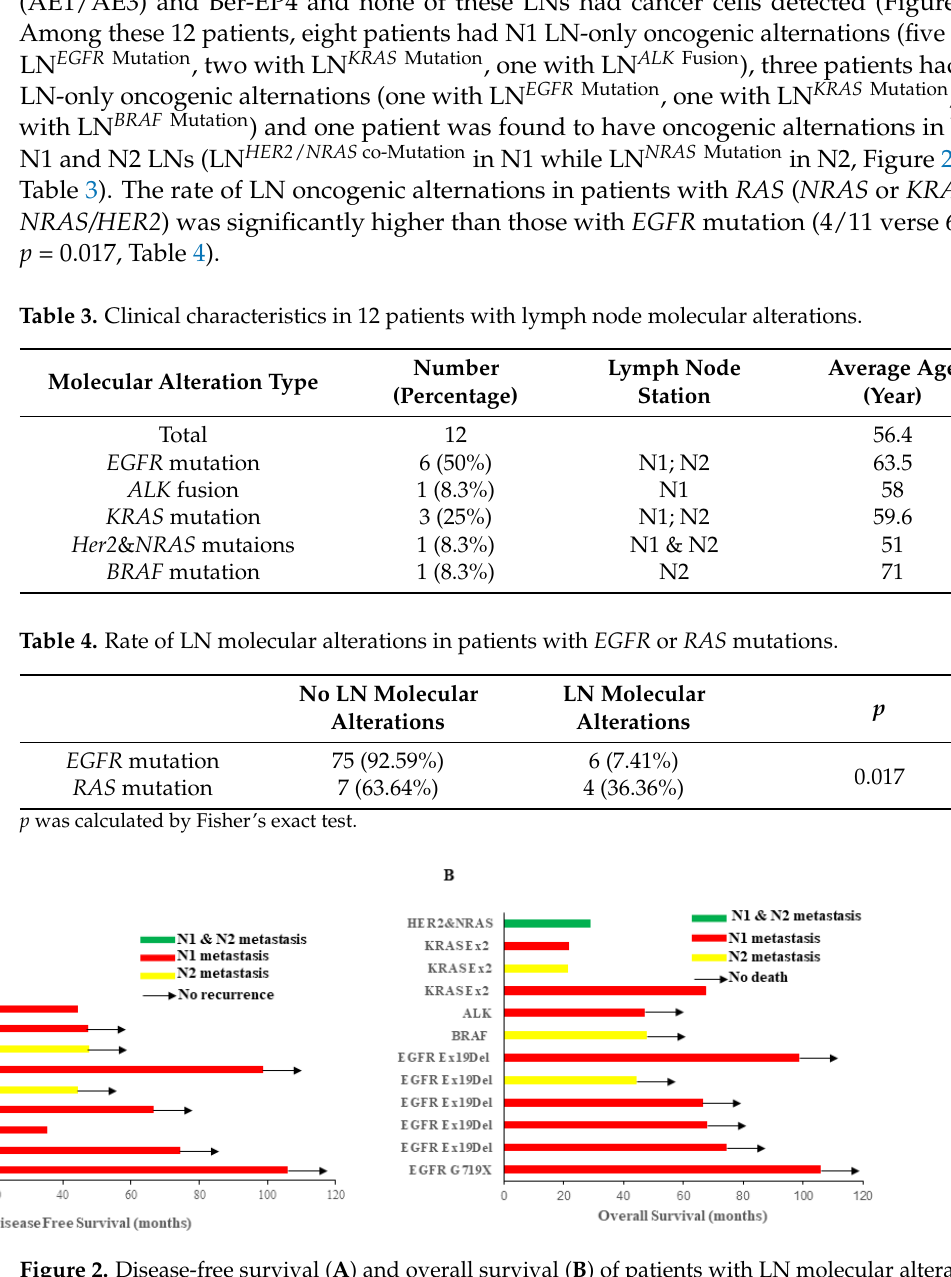
Figure 2. Disease-free survival ( A ) and overall survival ( B ) of patients with LN molecular alterations of different oncogenic mutations. Different colors represent those molecular alterations in different LN stations. Arrows indicate that patients had no recurrence or death.